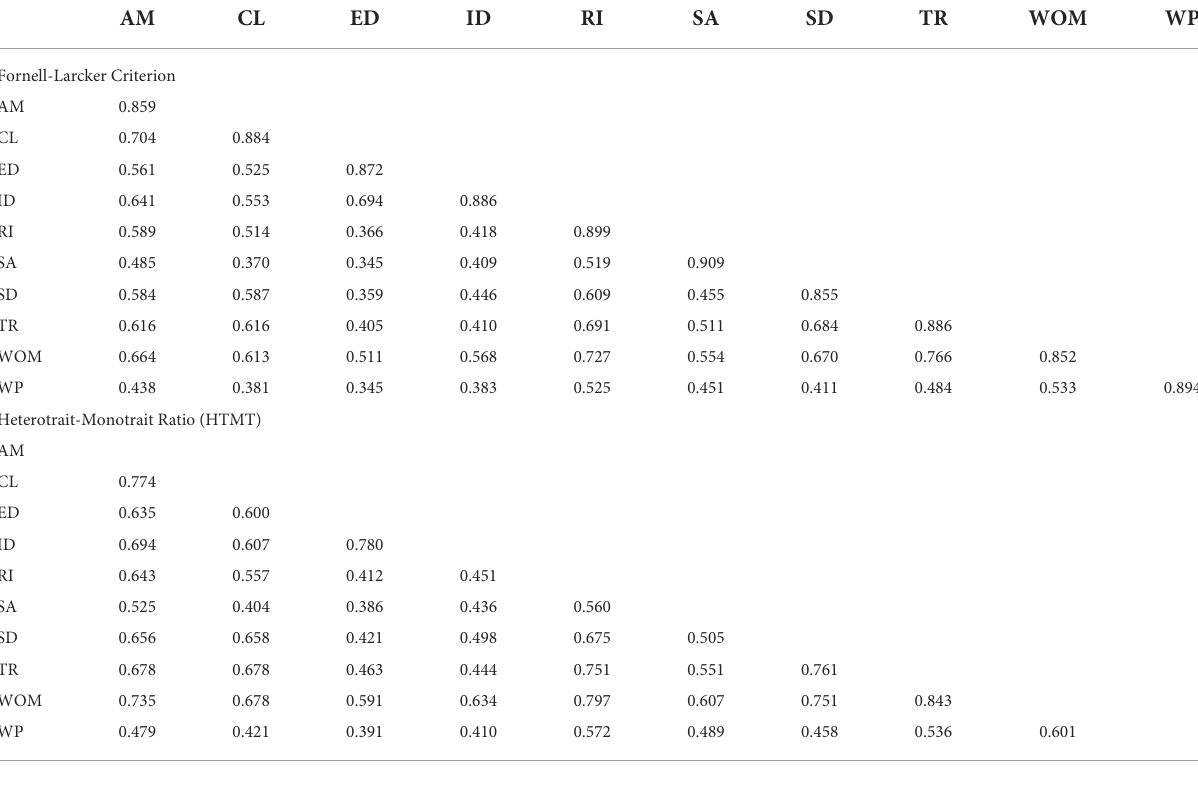
TABLE 5 Discriminant validity.